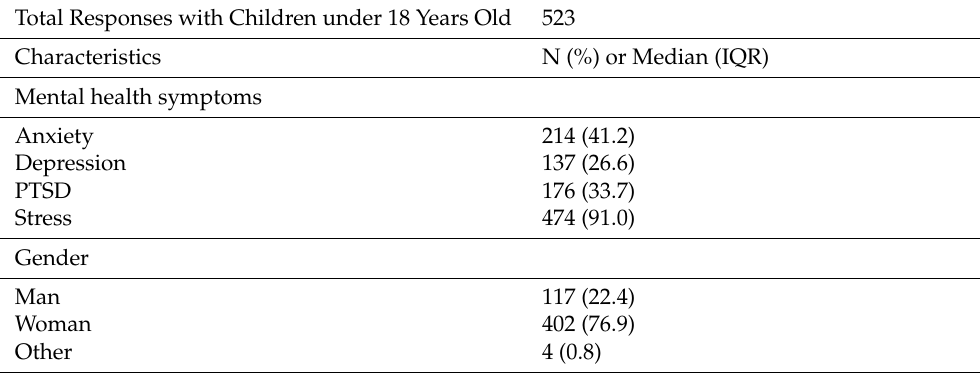
Table 1. Primary outcomes and baseline characteristics of respondents with children under 18 Years old completing the Speak Up on COVID Survey, May 2020–April 2021, New York